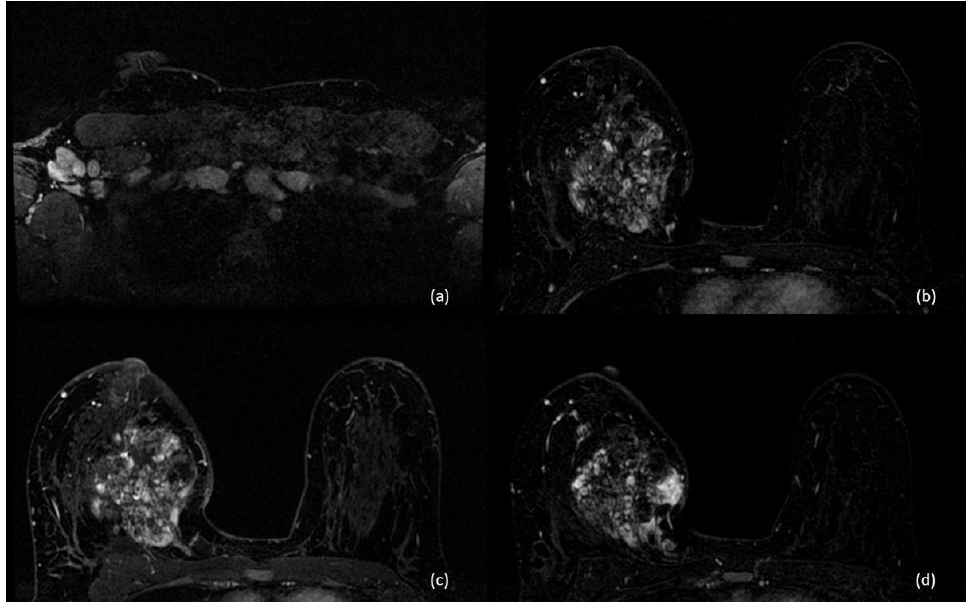
Figure 4. A 36-year-old breastfeeding patient, 6th month postpartum. CE-MRI of the breast shows ( a ) multiple enlarged highly suspicious lymph nodes in the right axilla and ( b – d ) a voluminous and heterogeneous mass enhancement, with central areas of necrosis and not circumscribed margins, located between the inner quadrants of the right breast. Histological examination revealed a G2 invasive lobular carcinoma; ER = 98%, PR = 1%, HER2-negative, Ki67 = 50% at immunohistochem- istry.